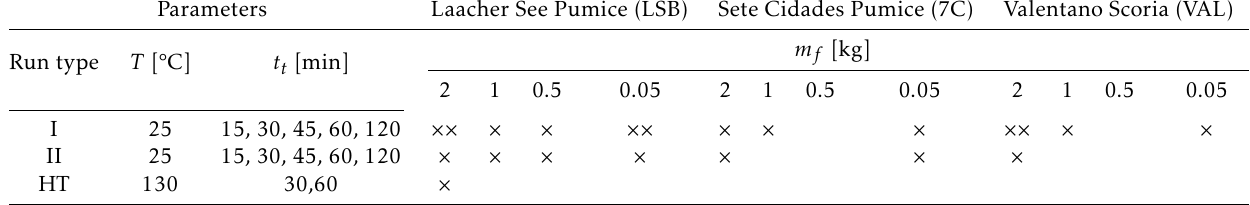
Figure 1: Experimental apparatus. The cement mixer used in this study for abrasion experiments at [A] ambient conditions and [B] elevated temperature. The use of two external gas burners allowed for in-drum temperatures up to 130 °C. A ceramic lid was used with a K-type thermocouple to monitor interior air temperature. Setup of the large drum with [C] the drum and fill dimensions and [D] the notation used to describe the bedload properties and dynamics on the backwall of the drum. The grey fill in [B] is shown for a bedload at rest following tumbling; properties during tumbling are shown in blue outline in both panels. Table 2 – The experiment run conditions and their corresponding abbreviations are listed for all 21 experiments. “ ” indicates experiments performed once. “ ” indicates experiments performed two times. Runs with 0.5, 1, × ×× and 2 kg starting material were performed in the large setup, whereas the small setup was used for the 0.05 kg experiments.